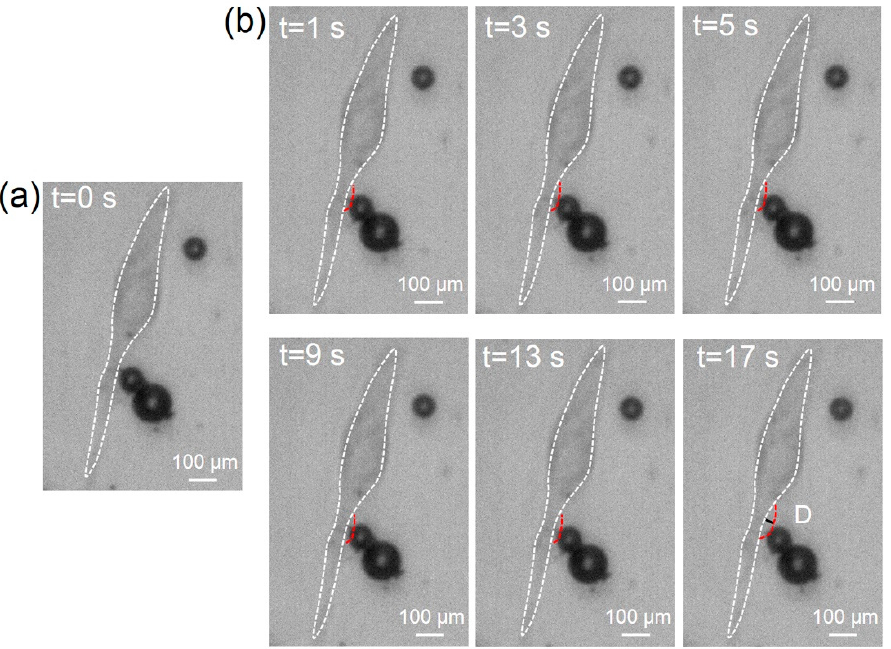
Figure 6. The deformation of the cell membrane during TSAW stimulation. ( a ) Optical image for original position of cells and TMBs. The TMBs tightly adhering to the cell during the whole process. ( b ) The deformation of cell membrane with TSAW excitation. The white dotted line represents the initial position of the cell, and the red dotted line shows the position of cell deformation in real time. D is the value of deformation at different times.